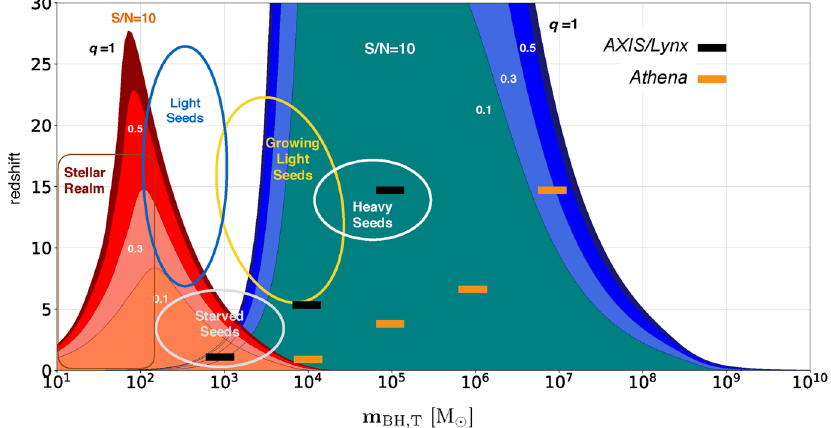
Fig. 27 LISA will be complemented by the X-ray mission Athena (launch expected in the early 2030s), and potentially by the NASA concept missions LynX and AXIS. These missions are shown in orange and black horizontal symbols, which indicate the sensitivity of the deepest pointing, in the [0.5 – 2] keV observed band, by Athena (orange) and LynX/AXIS (black). Waterfall plots show the average GW horizon computed for signal-to-noise ratio SNR ¼ 10 and different BH mass ratios for the Einstein Telescope (red) and LISA (blue/green) bandwidth (Santamaría et al. 2010; Hild et al. 2011; Robson et al. 2019). For reference, main MBH formation mechanisms are shown with ellipses. The growth of some of MBH seeds could be stunted by several processes and could be detectable only at late times when merging with other MBHs at z (cid:11) 5 ( “ starved MBHs ” in the white bottom ellipse, Valiante et al. 2021). Image reproduced by permissions from Valiante et al. (2021), copyright by the